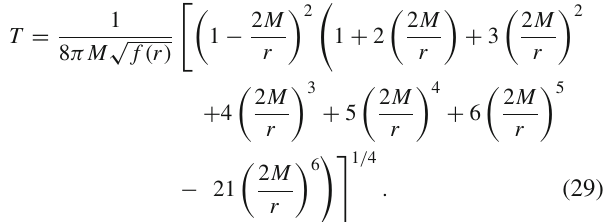
Hawking temperature in the noncommutative Schwarzschild black hole based on the different assumptions of quantization